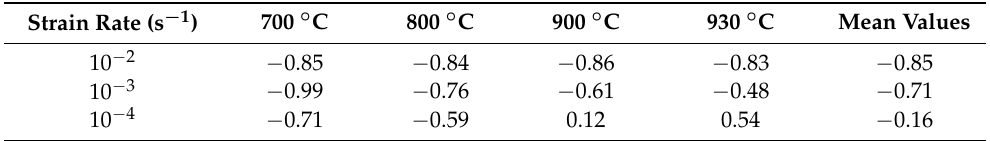
Table 11. Values for b from Equation